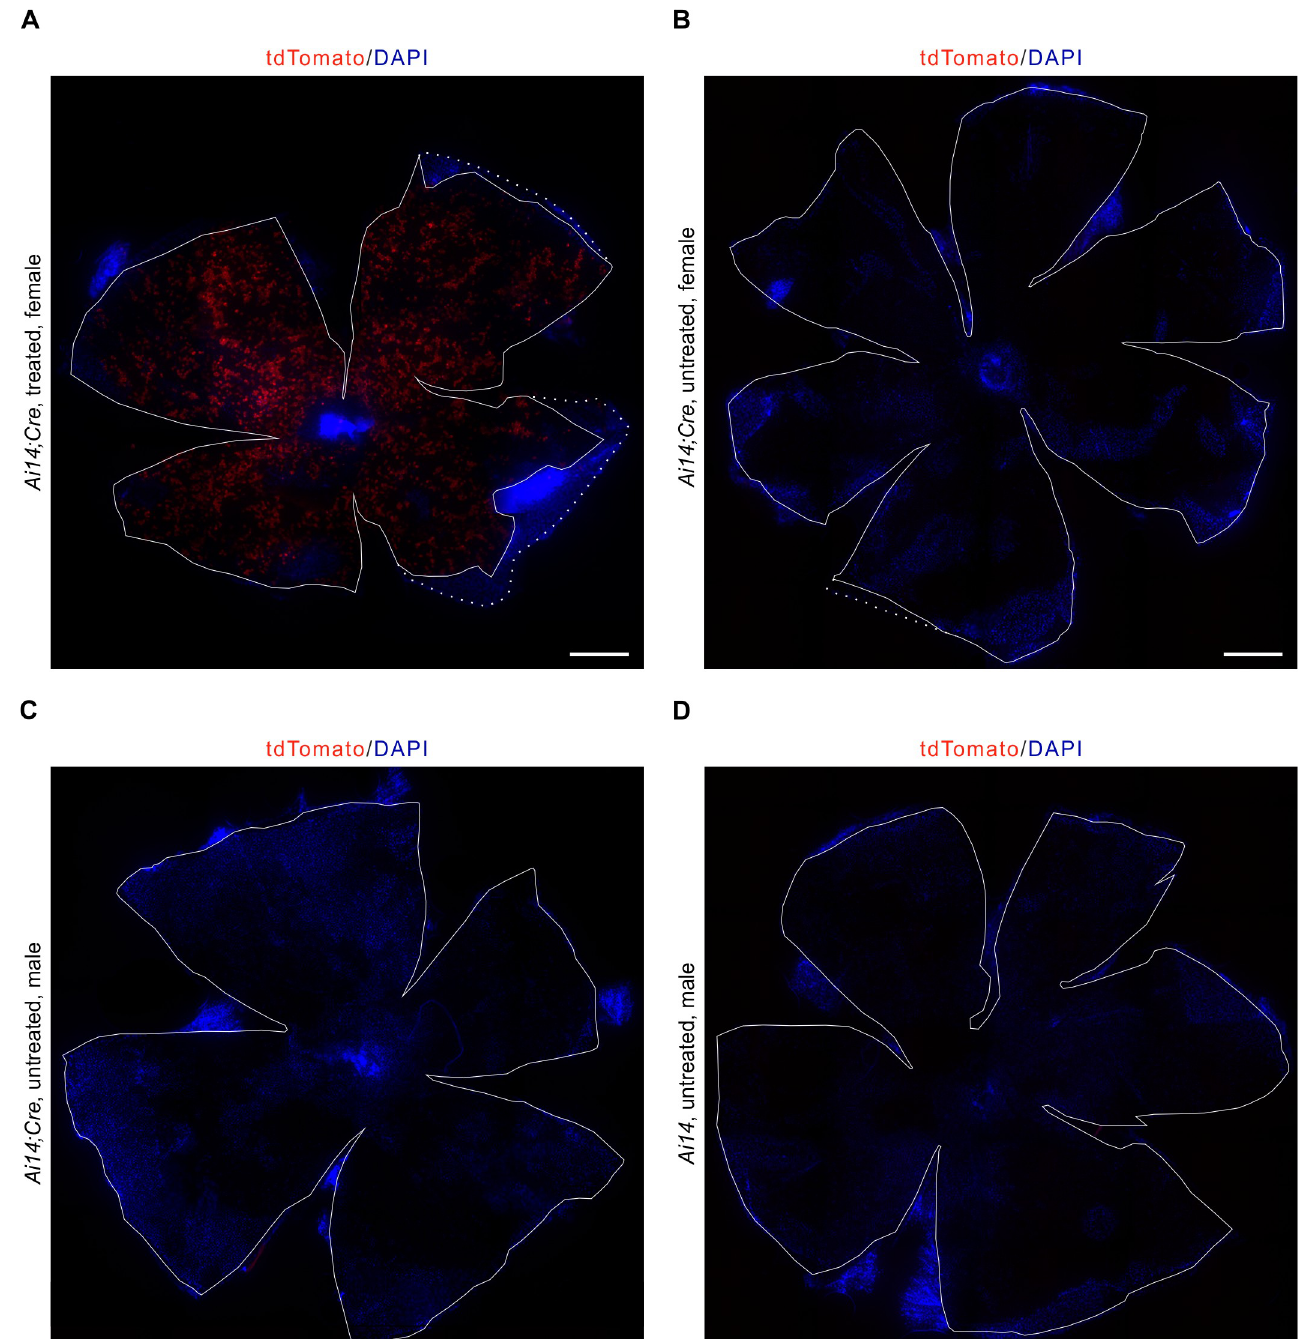
Fig 4. Representative RPE flatmount preparations from control animals. A: RPE flatmount of a treated female adult Ai14;RPE-Tyrosinase-CreEr T2 mouse showing tdTomato expression throughout the whole RPE. B: RPE flatmount of an untreated female adult Ai14;RPE-Tyrosinase-CreEr T2 mouse showing no red fluorescence, thus tdTomato expression. C: RPE flatmount of an untreated male adult Ai14;RPE-Tyrosinase-CreEr T2 mouse showing no red fluorescence, thus tdTomato expression. D: RPE flatmount of an untreated male adult Ai14 mouse, being Cre negative. No red fluorescence, thus tdTomato expression, was observed. All flatmounts were counterstained with DAPI (blue). Scale bar: (A-D) 500 μ m.